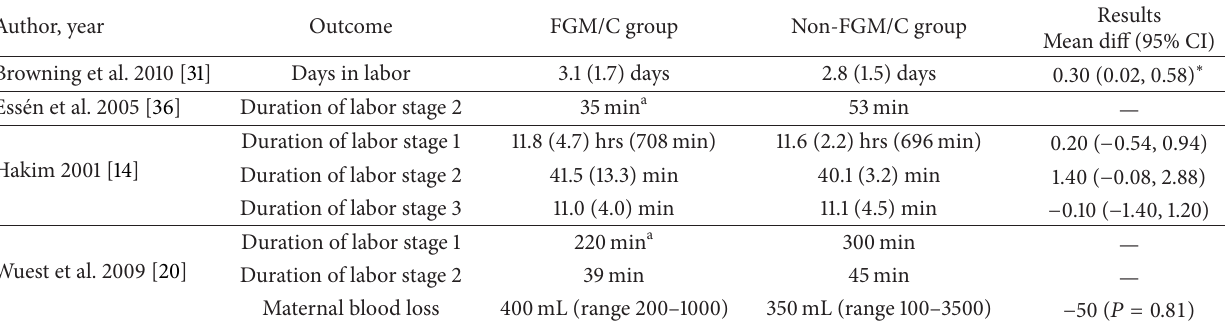
Table 2: Continuous study outcomes and effect estimates.